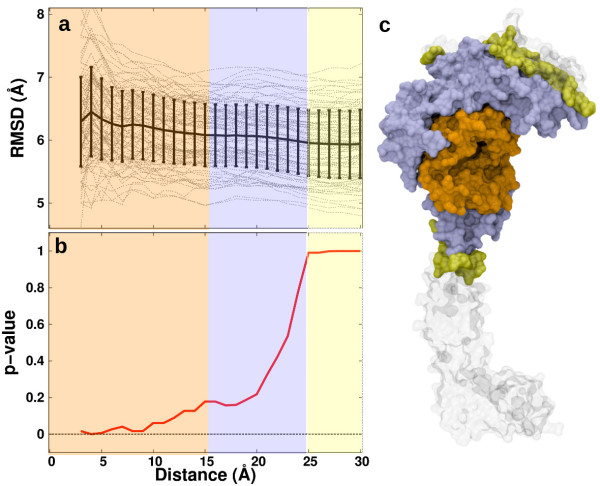
Statistical relevance of induced-fit vs. conformational selection mechanisms as a function of increasing distance from the H3-histone site examined by Kolmogorov-Smirnov tests. (a) The pairwise root-mean-square-deviation (RMSD) values between unbound and H3-bound conformation as a function of cumulative incremental distances of 1-Å from the binding site center of mass (gray lines); the average RMSD values (black line) and their standard deviation (vertical bars) are also shown. (b) p-values obtained using Kolmogorov-Smirnov tests (red line), comparing the statistical relevance of induced-fit vs. conformational selection as a function of the radial distance from the H3-histone site center of geometry; the background color coding corresponds to panel (c). (c) Structural regions of the LSD1/CoREST nanoscale clamp highlighted based on the p-value ranges. Note that the inner region encompasses entirely the H3-binding site. See also the Methods section for analysis details.